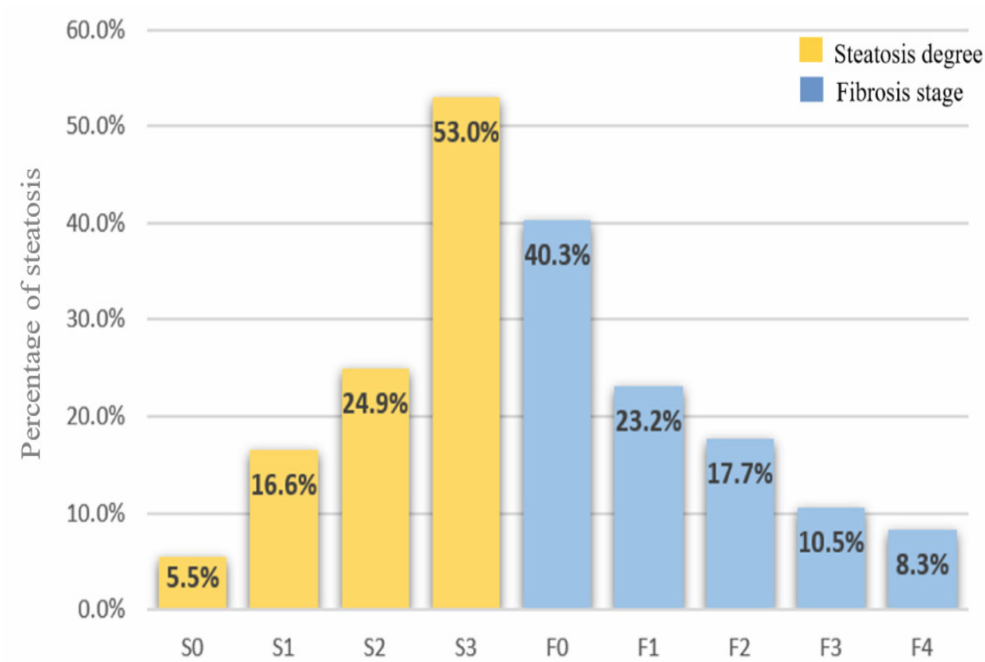
Figure 1. Proportion of patients according to steatosis degrees and fibrosis stages.